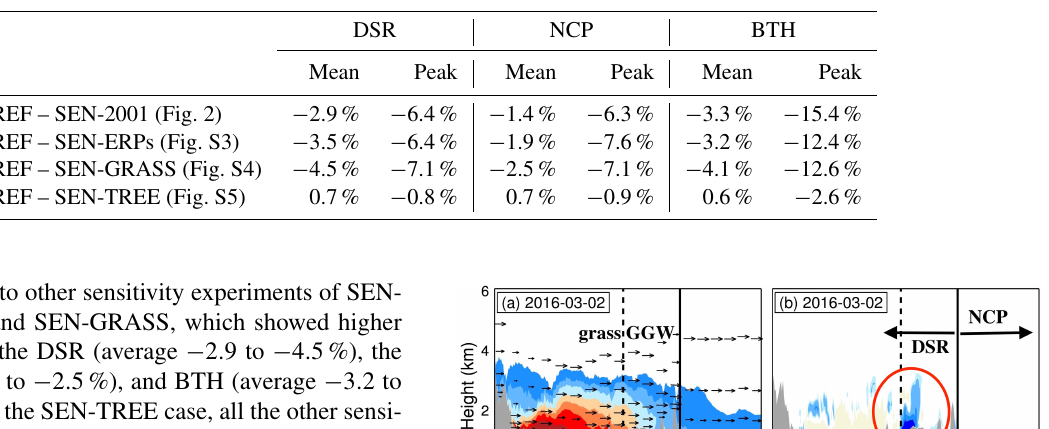
Table 1. The [PMC] change comparison of sensitivity experiments to the REF case. All the [PMC] changes are averaged at monitoring sites in the DSR, the NCP, and BTH.